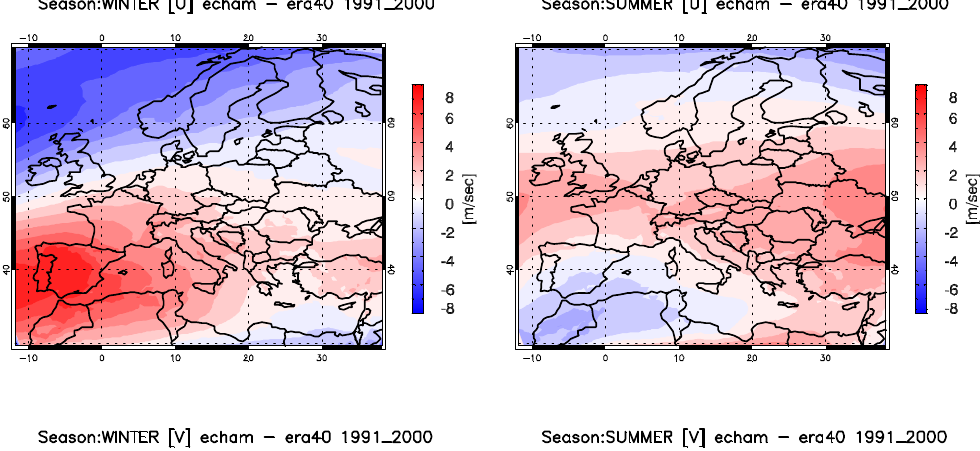
Fig. 6. Differences in simulated average 500hPa geopotential height fields between the ECHAM and ERA simulations for winter (left) and summer (right) representative of the 90s.